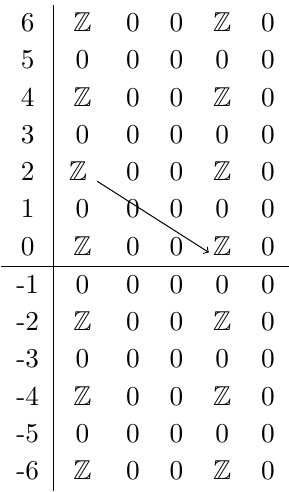
Table 15 . Second (and final) page of the AHSS for the computation of K − n ( S 3 ) . One of the d 3 differentials is shown explicitly. They all eventually